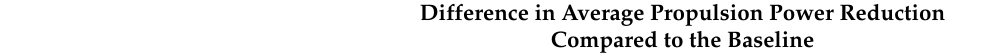
Table 4. Results of the sensitivity study for the ship with two Flettner rotors.